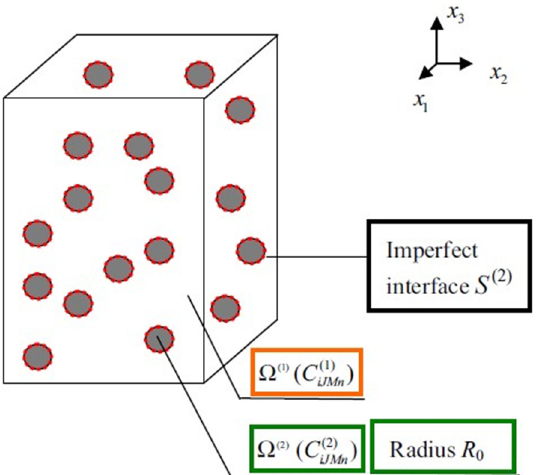
Figure 4. Schematic illustration for composite materials with imperfect interface. Reprinted with permission from ref. [92]. Copyright 2016 IEEE.